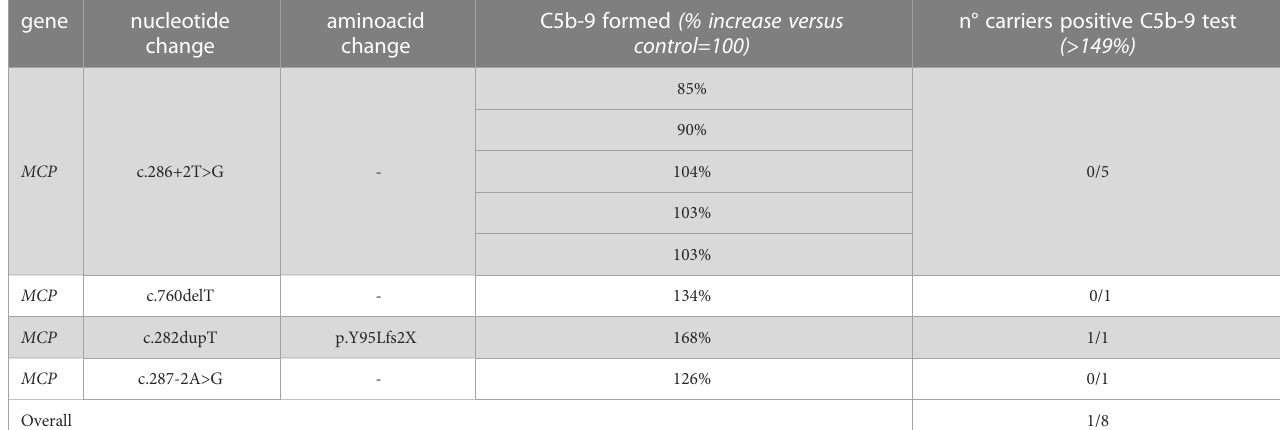
gene nucleotide